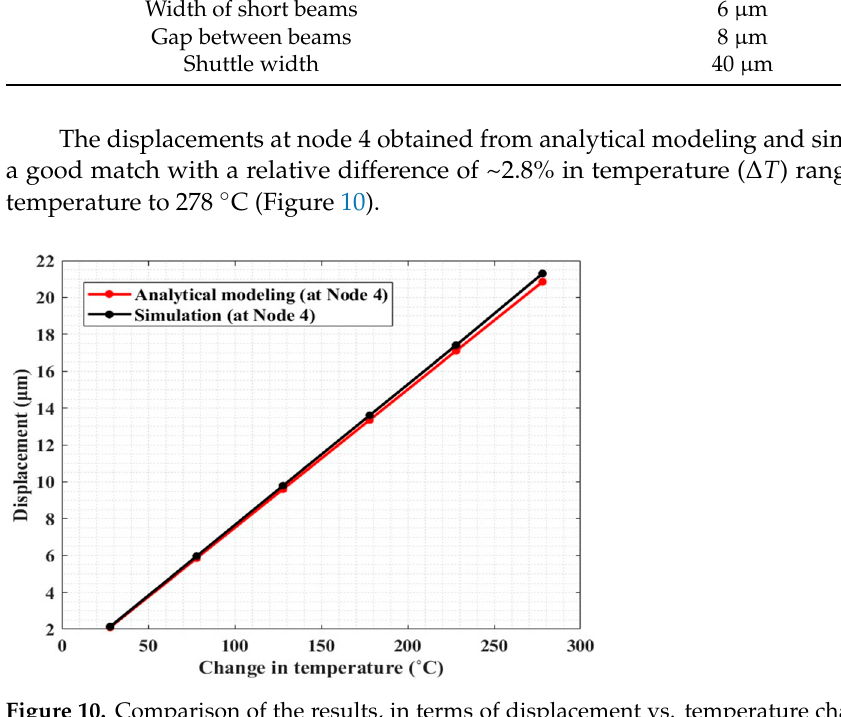
Figure 10. Comparison of the results, in terms of displacement vs. temperature change, obtained from analytical modeling and finite element simulations of the electrothermal actuator.